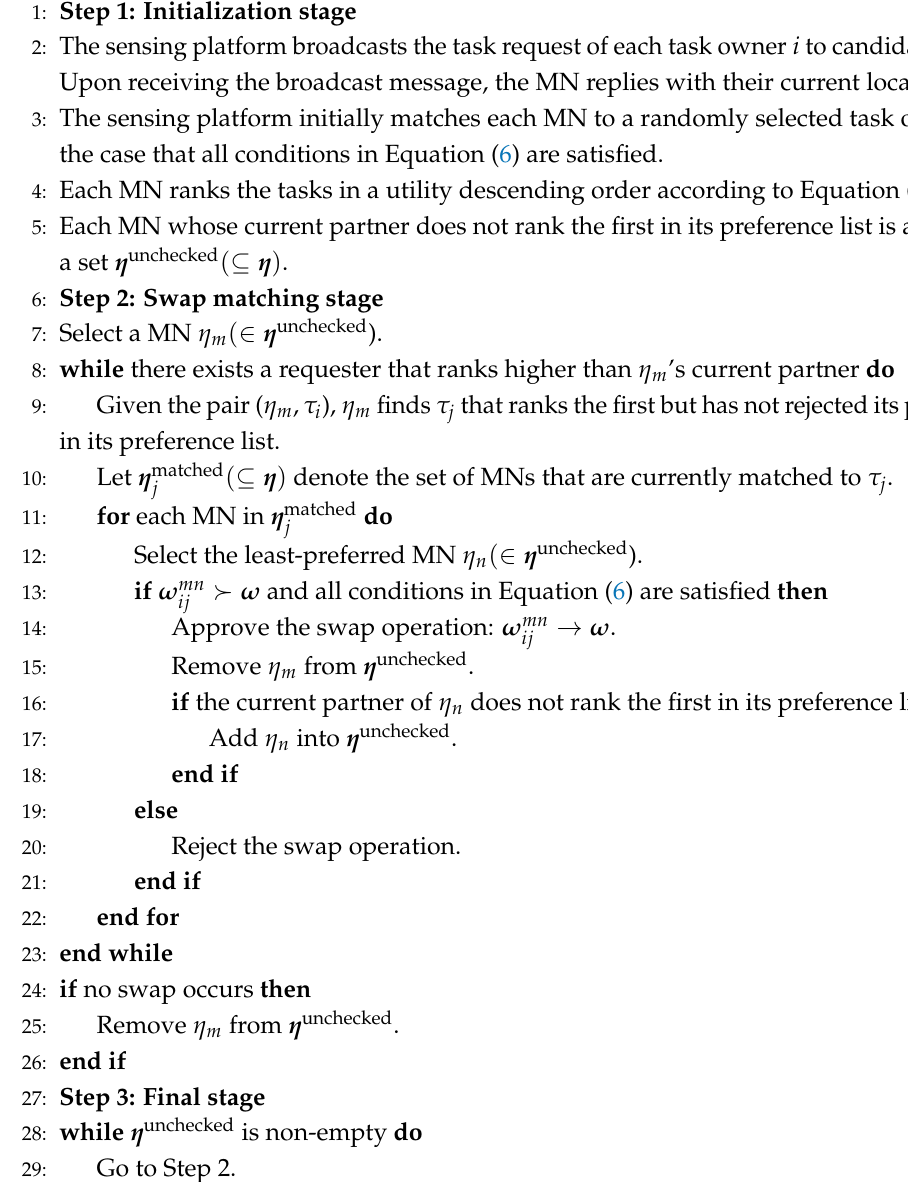
Algorithm 1 The proposed matching